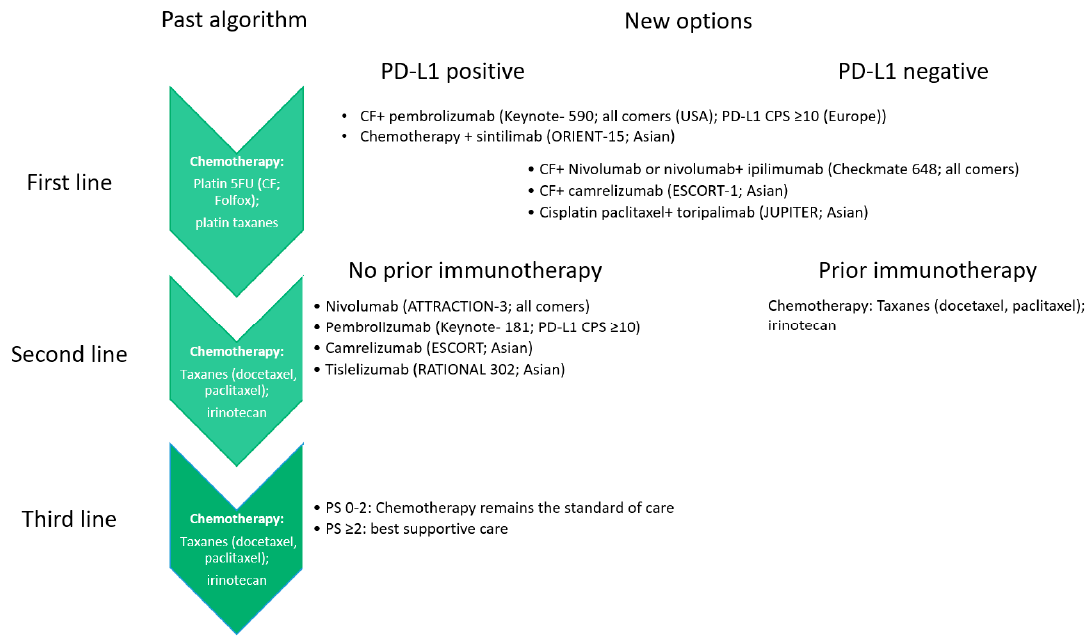
Figure 1. How immunotherapy has changed the treatment algorithm for metastatic ESCC. Abbreviations: 5FU: fluorouracil; CF: cisplatin, fluorouracil; PS: performance status according to ECOG scale; PD-L1: programmed death ligand-1; CPS: combined positive score.